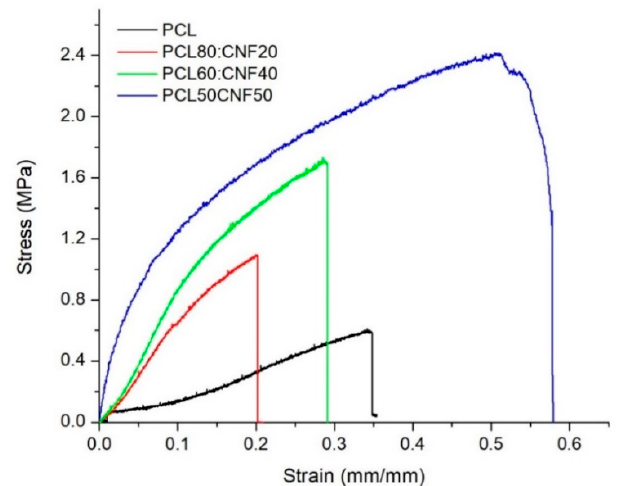
Figure 5. Stress–strain curves of polycaprolactone (PCL) and electro-spun membranes of 50:50, 60:40, and 80:20 PCL/CNF ( v / v ) ratios.